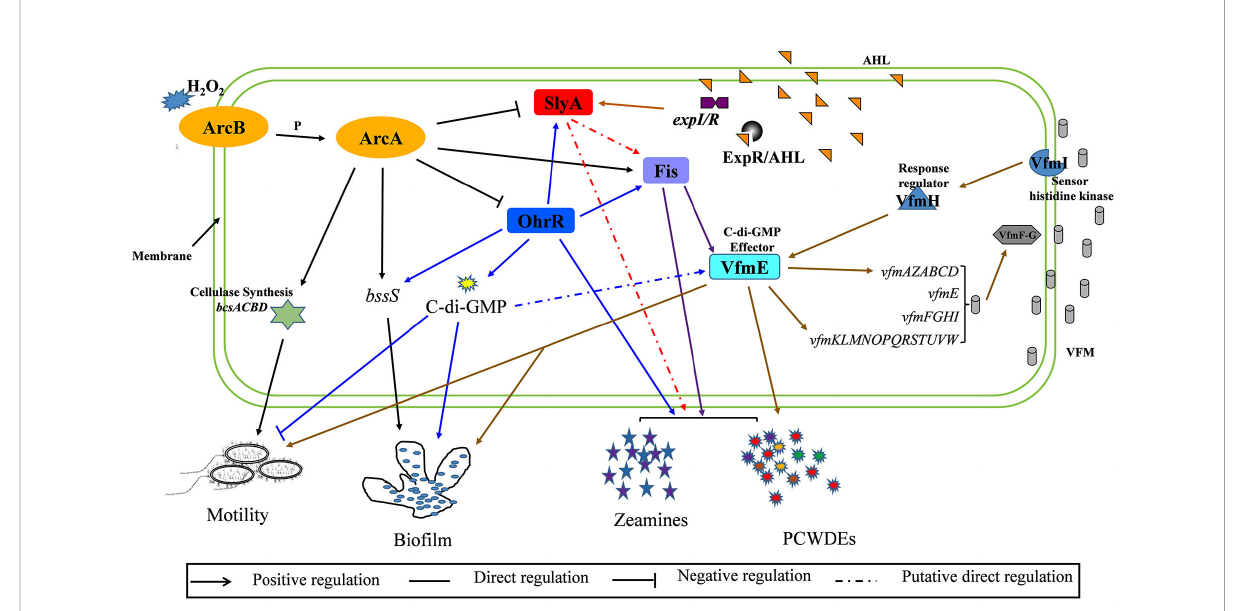
FIGURE 7 A schematic map of ArcBA modulating downstream genes in Dickeya oryzae EC1. ArcA modulates bacterial motility and bio fi lm formation by directly binding to the promoter region of bcsA . ArcA also directly and positively regulates the transcription of fi s , and negatively regulates the transcription of slyA and ohrR